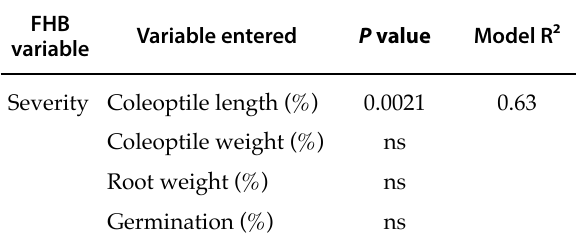
Table 6. Multivariate analysis of independent variables in a Fusarium graminearum -mediated Petri dish test (average of three experiments) using backward selection to explain FHB severity (average of two experiments) under green-